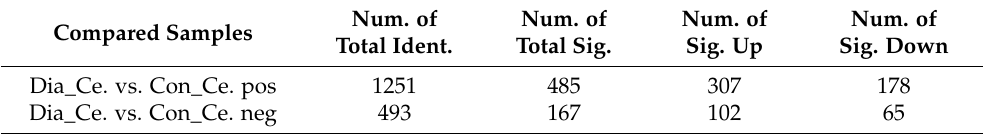
Table 4. Screening results of metabolites